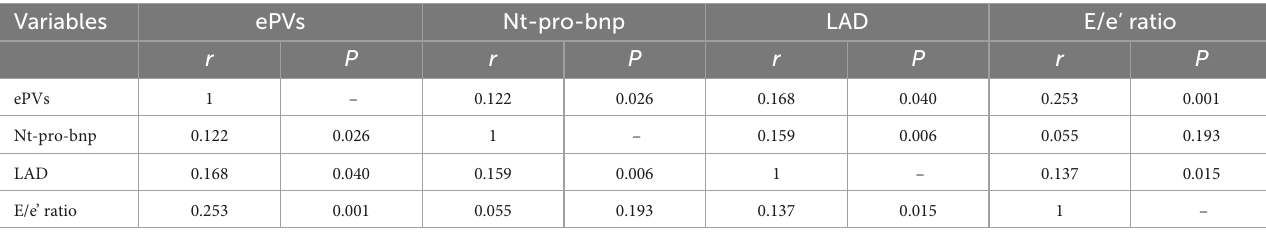
TABLE 3 Correlation of indicators.